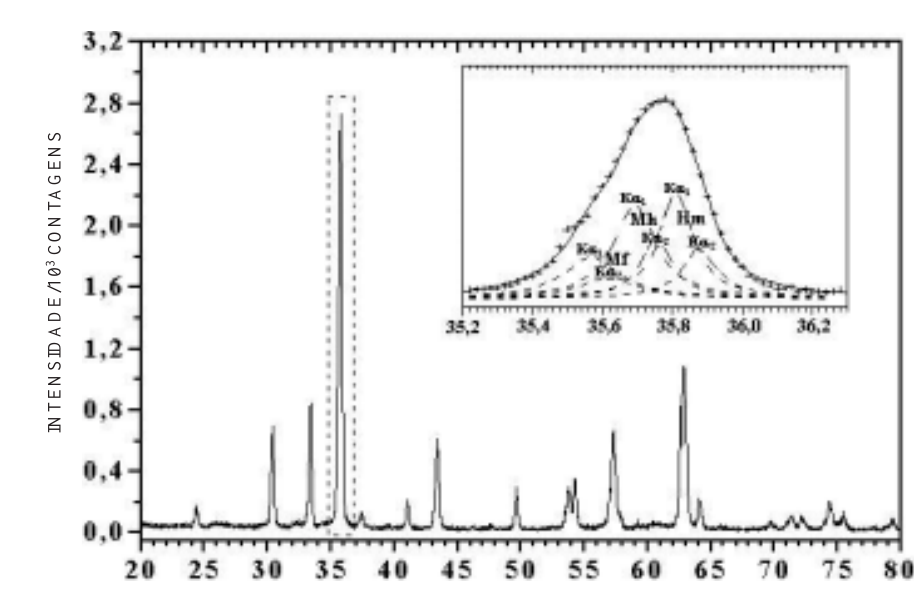
Figura 4. Difratograma de raios X da fração magnética da amostra AP33CR. Detalhe da deconvolução da região assinalada (destaque, na figura) no difratograma, nos componentes relativos às reflexões (311), para a magnesioferrita e maghemita, e (110) para a